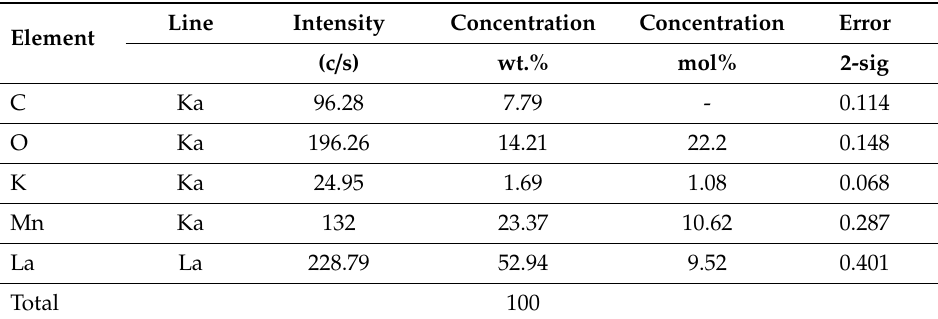
Figure 4. SEM and EDS map of La 0.9 K 0.1 MnO 3 powder. Figure 4 . SEM and EDS map of La 0.9 K 0.1 MnO 3 powder. Table 2. EDS spectrum analysis of La 0.9 K 0.1 MnO 3 Table 2 . EDS spectrum analysis of La 0.9 K 0.1 MnO 3 powder.